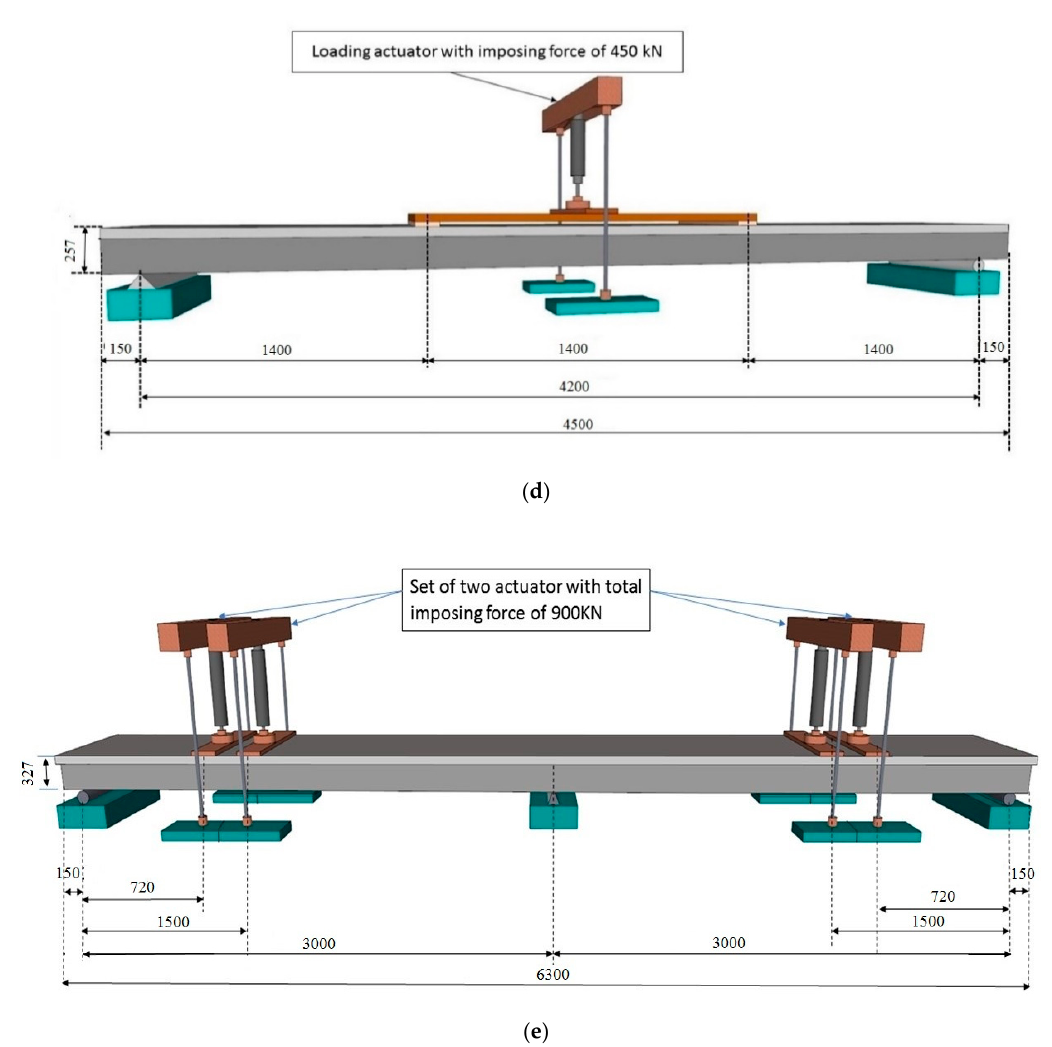
Figure 3. Experimental setup for slip measurements (m); ( a ) Loading system of SPBs ( b ) Loading system of ECBs; ( c ) Arrangement of dial gauges; ( d ) Schematic view of SPBs (mm); ( e ) Schematic view of ECBs